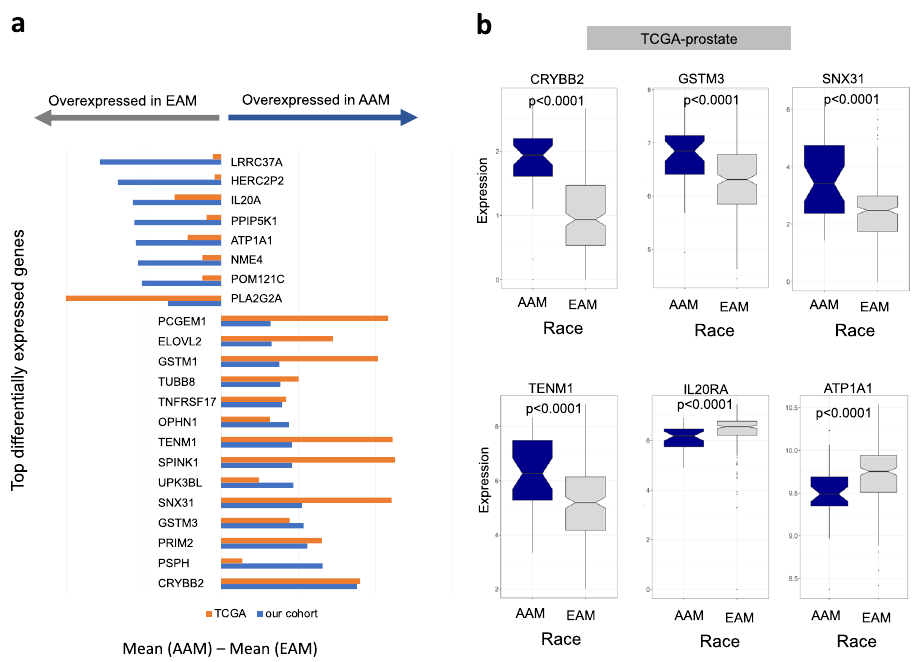
Fig. 2 Genome-wide differential expression in AAM and EAM. a Top 22 genes differentially expressed between the two groups in our cohort with multivariate analysis logistic regression P value <1e − 10 . Mean difference in TCGA prostate was also shown for these genes to show that these genes show the same directionality. Genes were sorted based on the mean difference between AAM and EAM. b Boxplot of genes differentially expressed in TCGA prostate cohort. Abbreviations as in Fig. 1. Error bars represent the 95% con fi dence